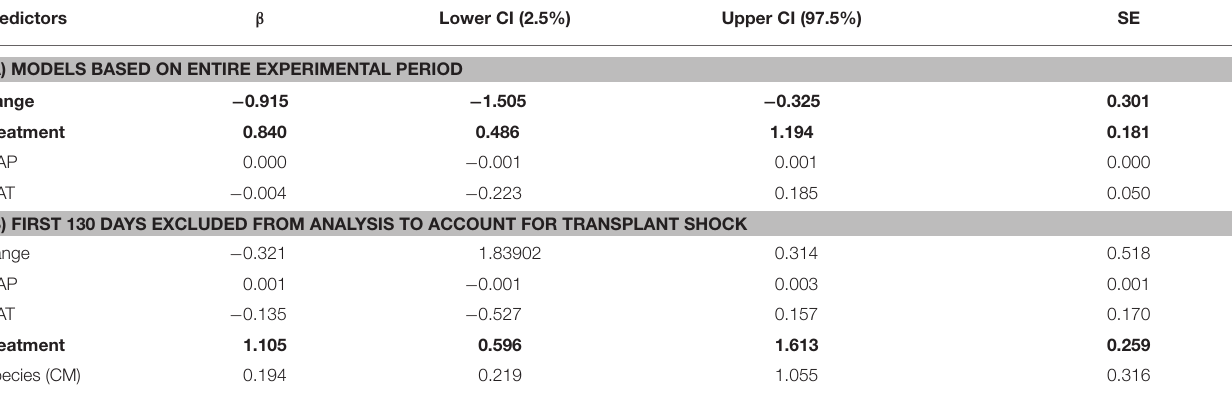
TABLE 3 | Final parameter estimates ( β ), standard errors (SE) and confidence intervals of model averaging based on top models for (A) analysis of entire experimental period and (B) analysis excluding first 130 days to account for effects of tranplant shock. Predictors β